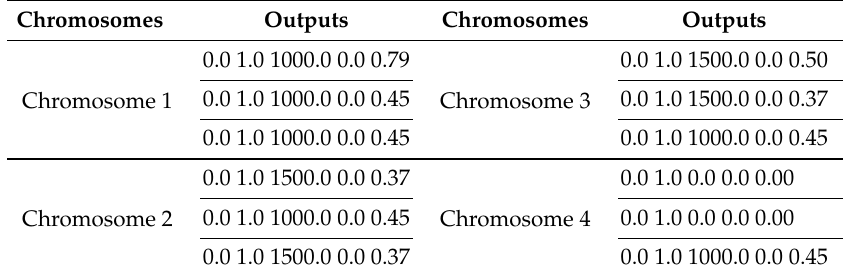
Table 3. Outputs of chromosomes from the genetic decision probe (GDP)